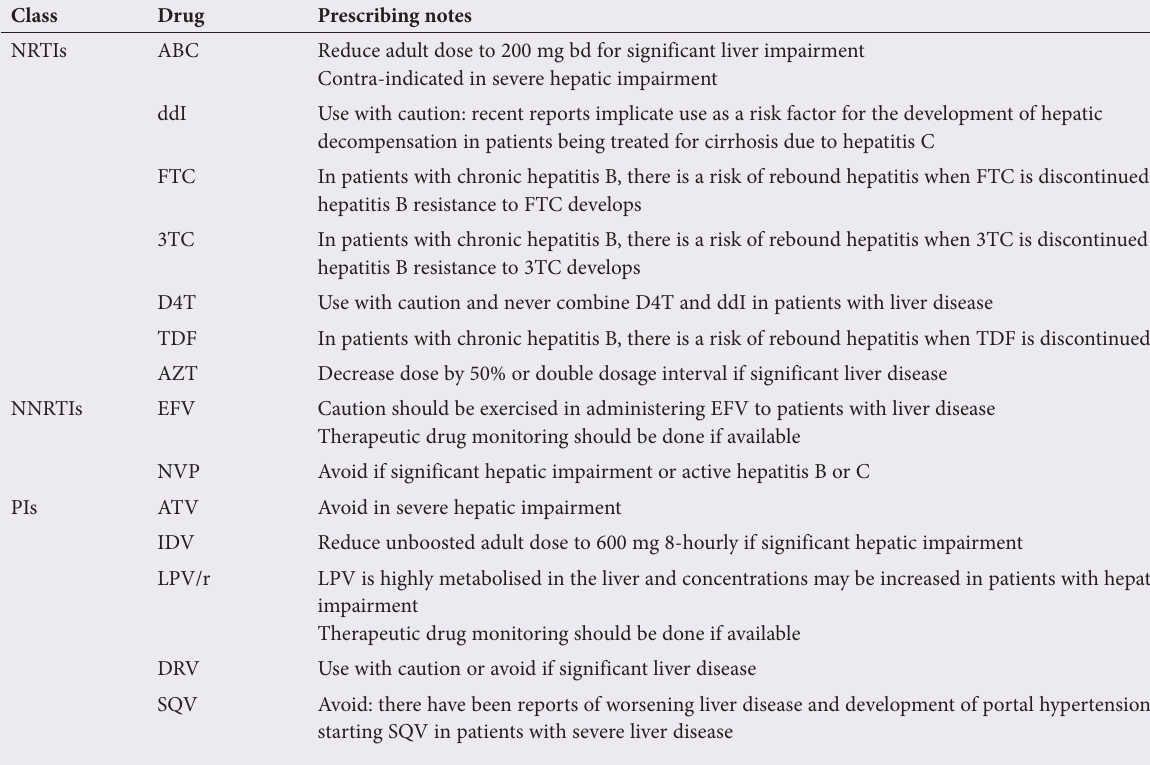
Table 10. Prescribing ARVs in liver